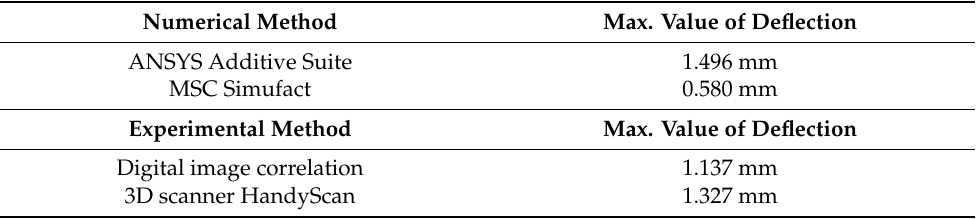
Table 5. Numerical and experimental results of the maximal deflection of the